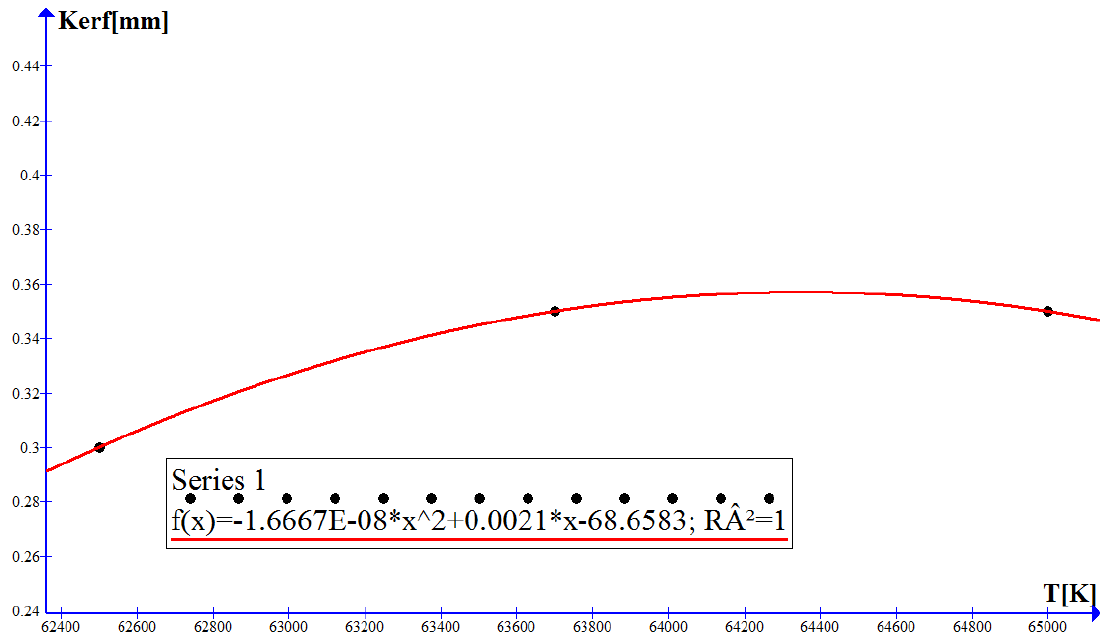
Figure 6. Dependence of cutting width as a function of temperature.